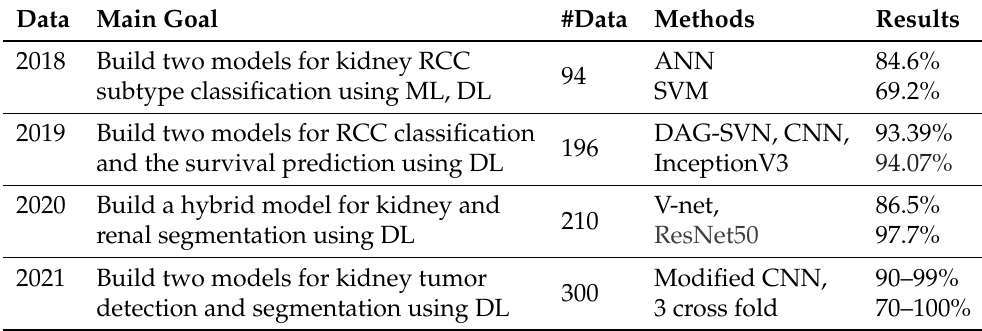
Table 6. The outcomes of the related multi-model tumor